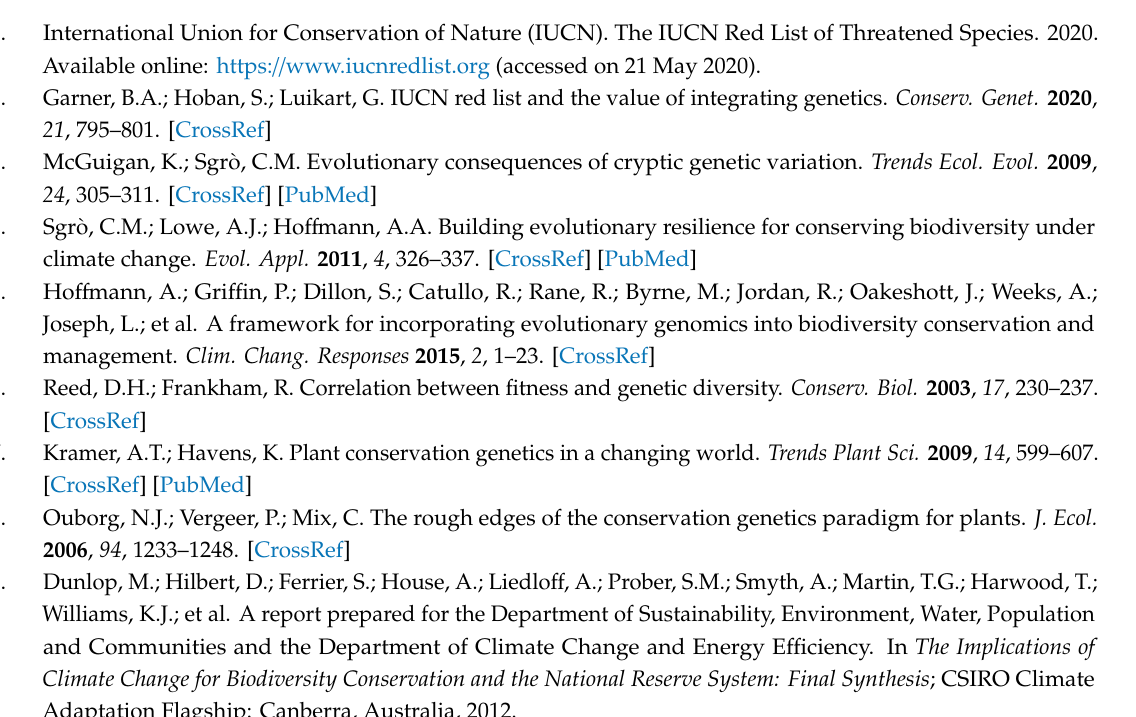
Figure S1: All regions. DAPC: Bayesian information criterion (BIC) and assignments; fastStructure: DeltaK / ProbK. Figure S2: Central + northeast. DAPC: BIC, DAPC plot, assignments; fastStructure: DeltaK / ProbK. Figure S3: Southwest. DAPC: BIC, DAPC plot, assignments; fastStructure: DeltaK / ProbK. Figure S4: Haplotype network and geographic distribution of haplotypes based on mapping of ddRADseq loci to chloroplast reference genomes. Figure S5: Percentage contributions of soil and climate variables when modelling the distribution of e on the basis of occurrence data. Table S1: List of variables used for modelling suitable habitat for Sclerolaena napiformis . Table S2: Analysis of molecular variance among disjunct southwest, central, and northeast regions of Sclerolaena napiformis . Table S3: Analysis of molecular variance among southwestern Sclerolaena napiformis sites. Table S4: Analysis of molecular variance among central Sclerolaena napiformis sites. Analysis includes investigations of variance (a) between Victoria and New South Wales (states are divided by the Murray River), and (b) among all sites without consideration of state variable. Table S5: Analysis of molecular variance among northeast Sclerolaena napiformis sites. Table S6: Lower, mean and upper FIS estimates for each collection site of Sclerolaena napiformis